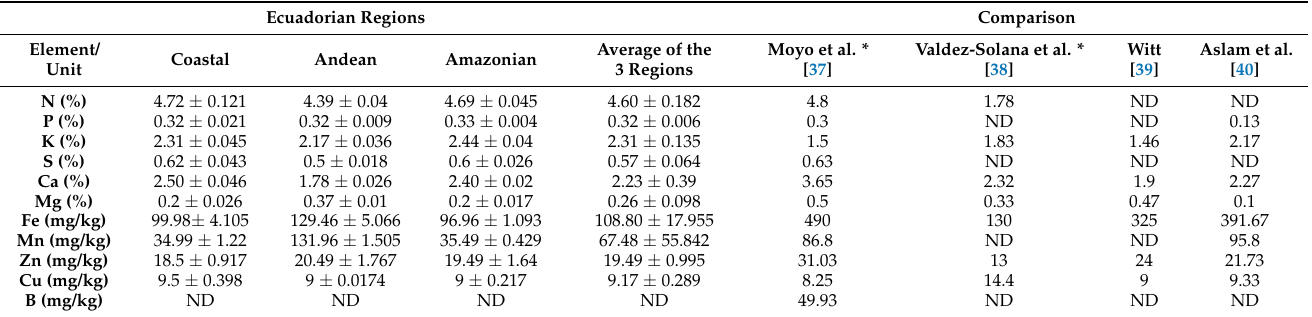
Table 2. Abiotic components from the studied regions in agreement with leaf analysis.